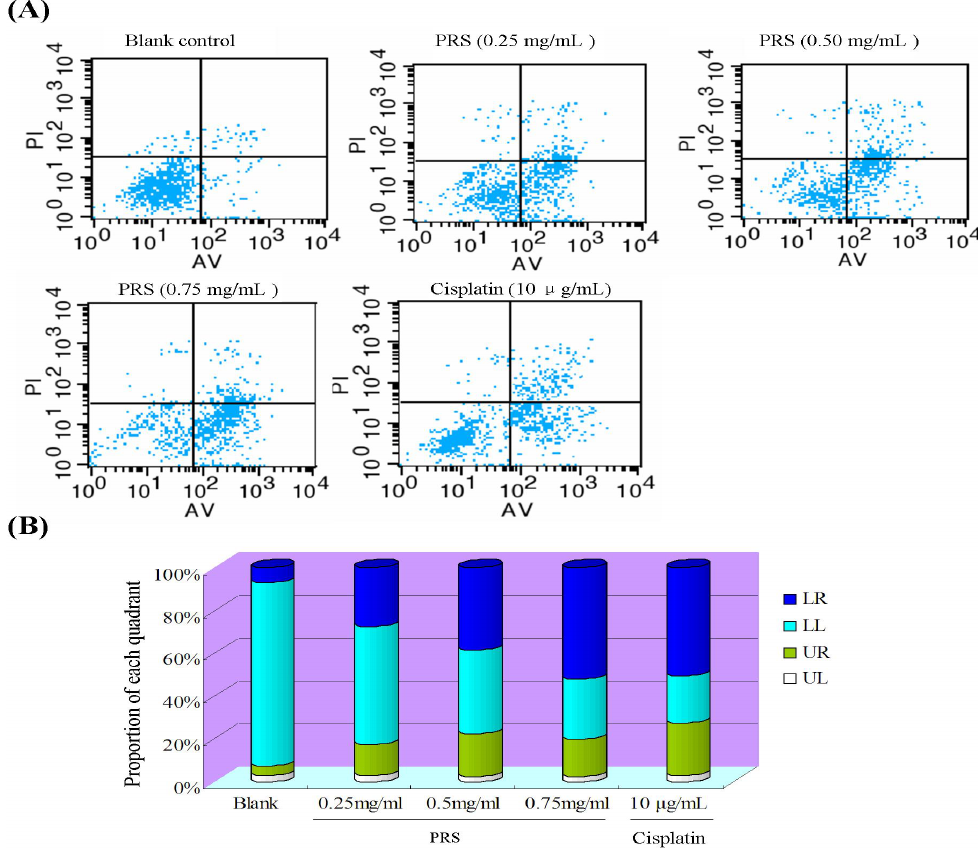
Figure 7. Effect of PRS on annexin V/PI-stained apoptosis in A549 cell by flow cytometry. A549 cells were exposed to PRS (0.25, 0.50 and 0.75 mg/mL) and positive control cisplatin of (10 μ g/mL) for 24 h. ( A ) annexin V/PI images; ( B ) the ratio of different